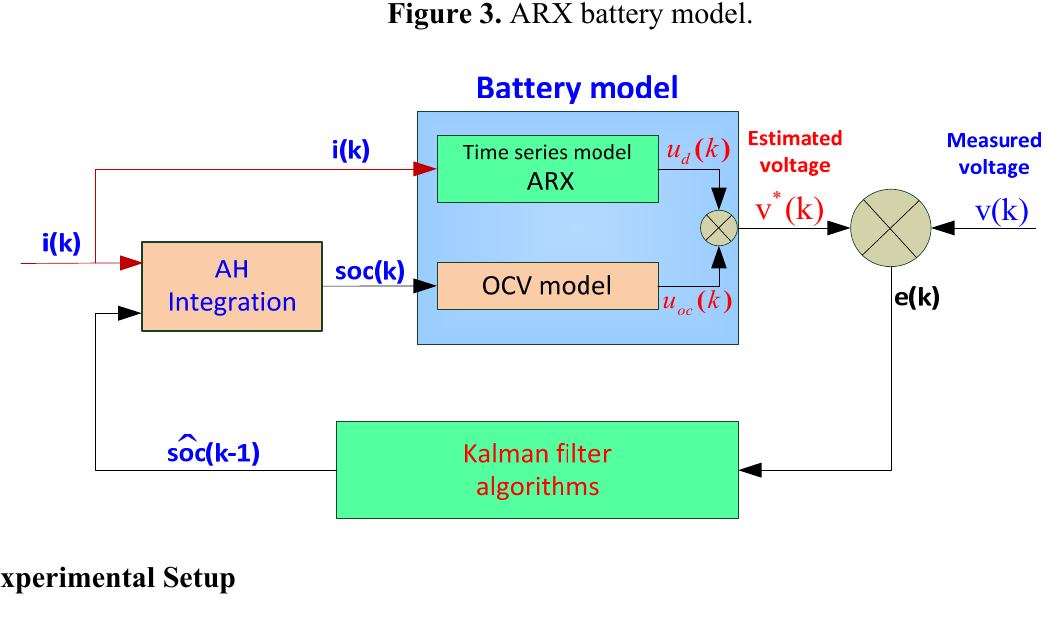
Figure 3. ARX battery model.